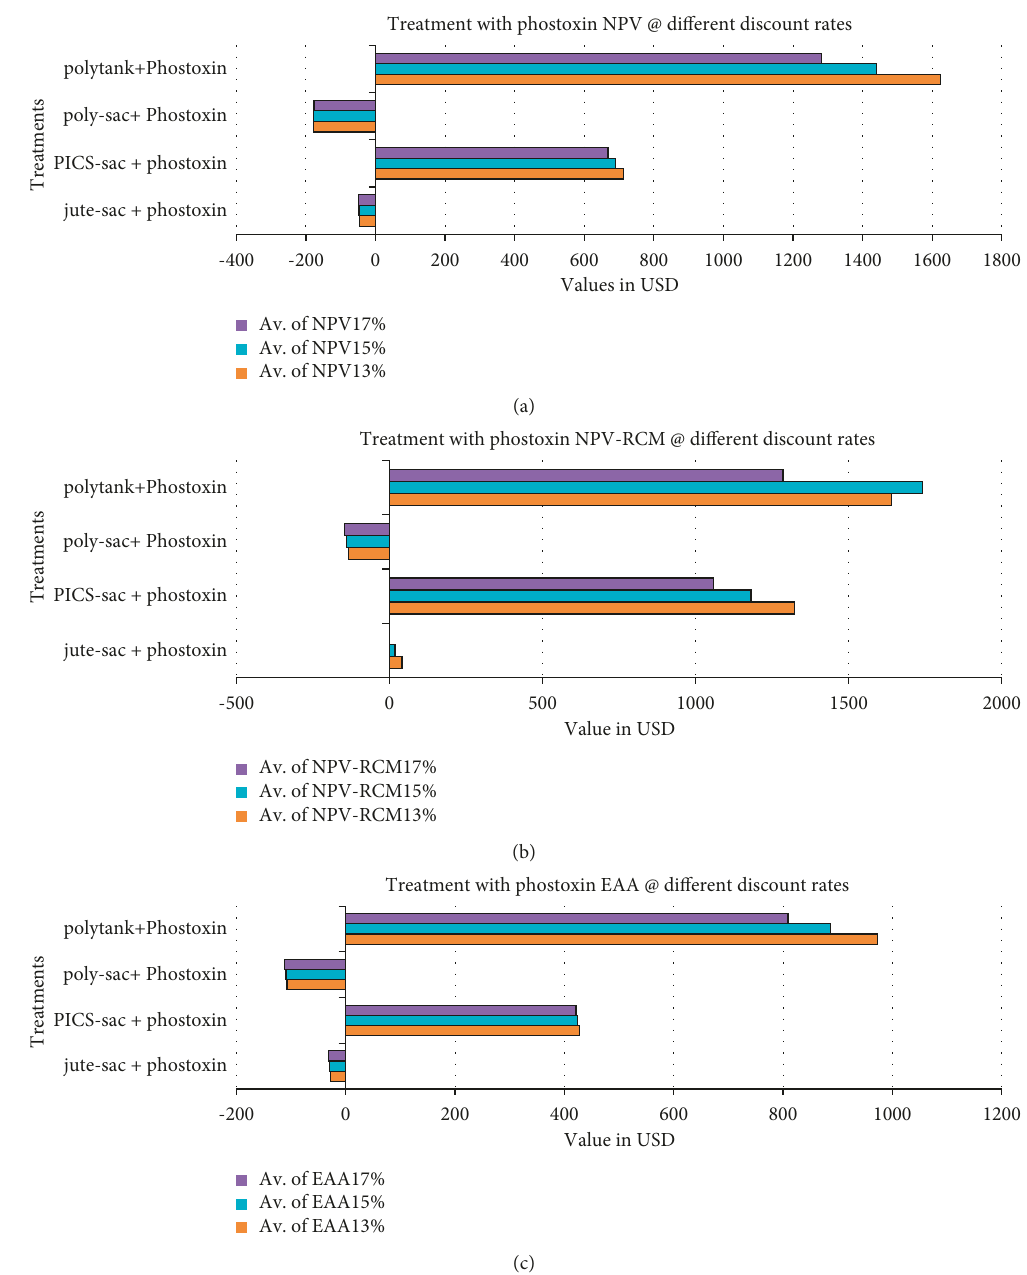
Figure 11: Performance of storage techniques treated with Phostoxin in